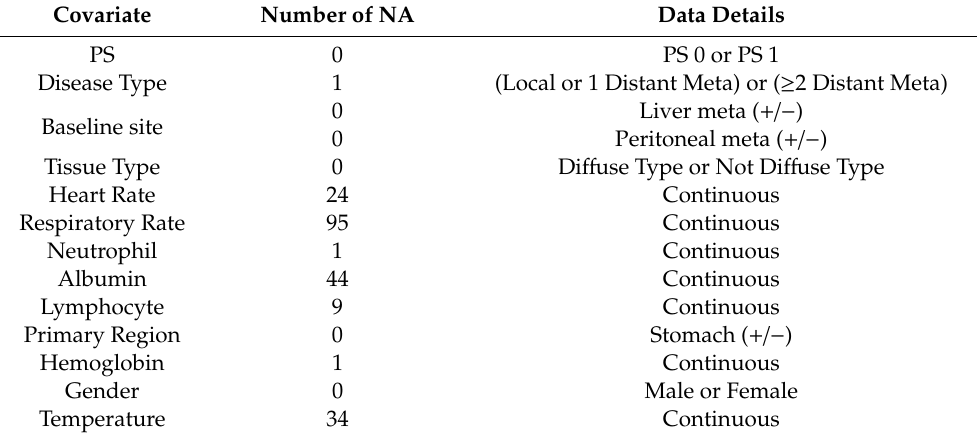
Table 2. Selection of the 14 clinico-pathological factors in FLAGS trial.